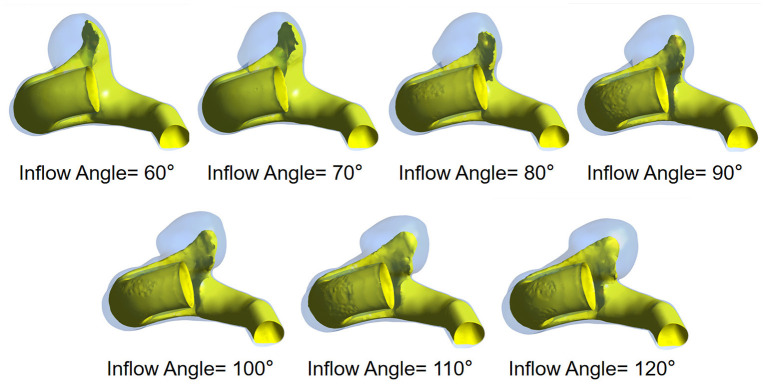
The inflow jet of seven IA models exhibiting different inflow angles at peak systole.